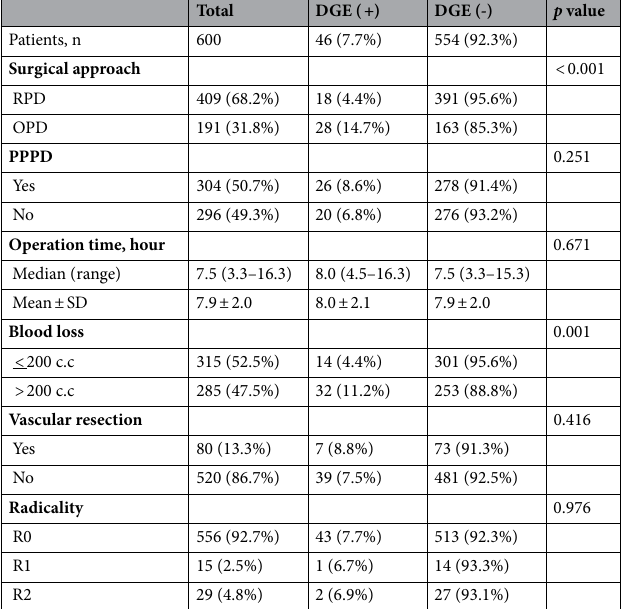
Table 3. Intraoperative factors for DGE after pancreaticoduodenectomy. DGE delayed gastric emptying, RPD robotic pancreaticoduodenectomy, OPD open pancreaticoduodenectomy, PPPD